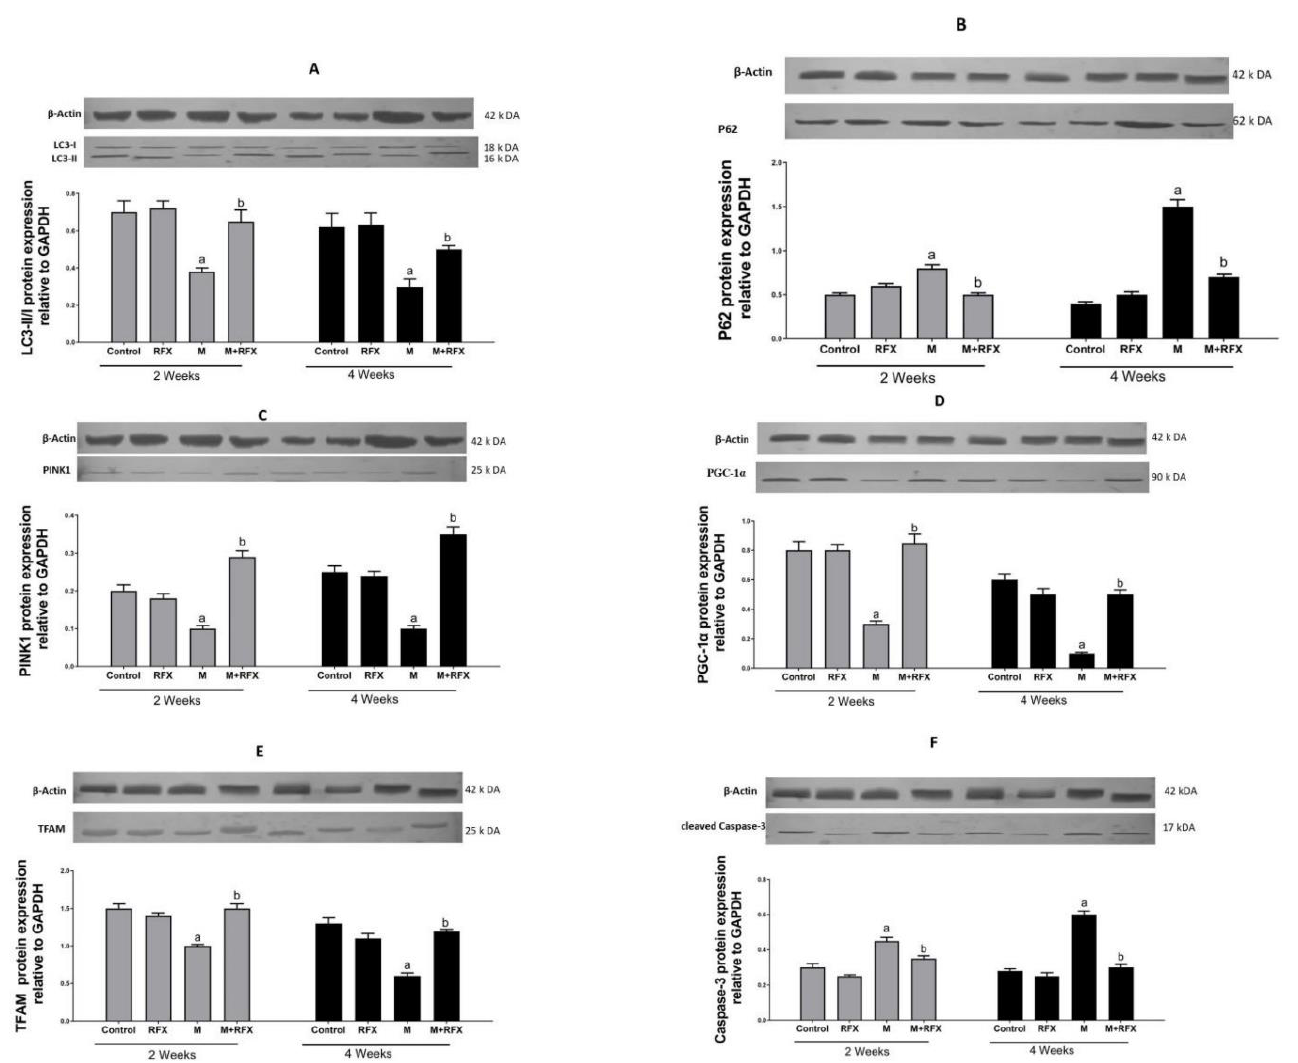
Figure 13. Effect of RFX administration on protein expression of LC3-II/LC3-I ( A ), P62 ( B ), PINK1 ( C ), PGC-1 α ( D ), TFAM ( E ), and cleaved Caspase-3 ( F ) in the testicular tissue of rats exposed to malathion as shown by Western blot analysis. Bars represent protein expression levels relative to GAPDH. Values are expressed as the means ± SEM. a, significant ( p < 0.05) versus control; b, significant ( p < 0.05) versus malathion group; one-way ANOVA followed by Bonferroni-corrected post hoc tests were performed.